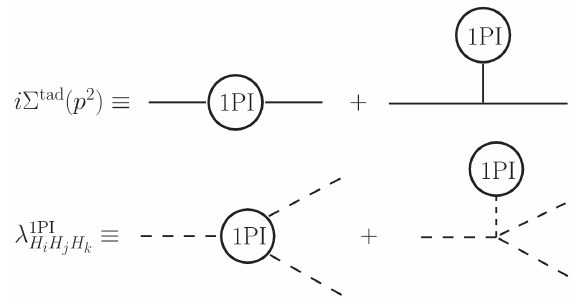
Figure 9 . Self-energy diagrams and triangle vertex diagrams in the alternative tadpole